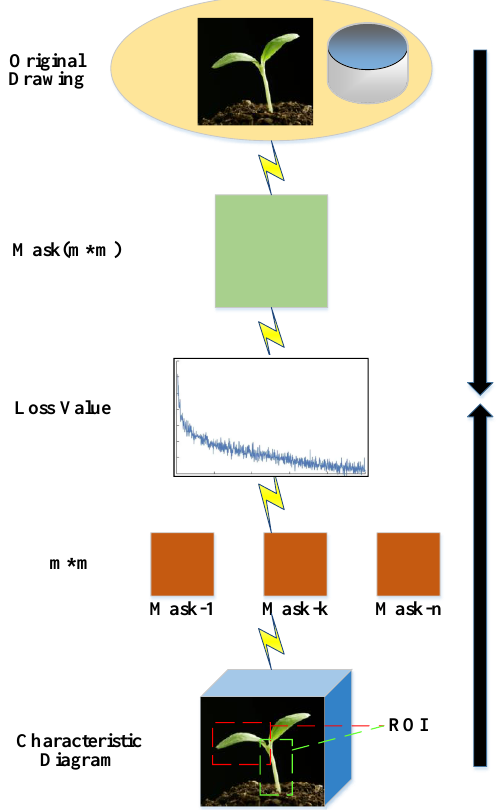
Figure 3. Schematic diagram of the multitask loss function in MRCNN.